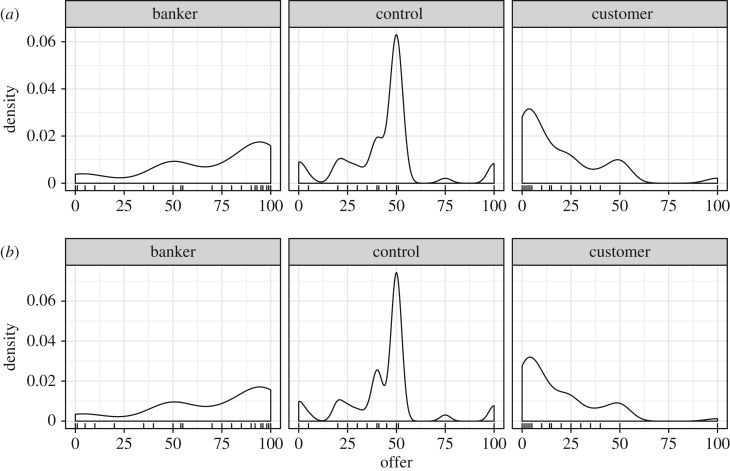
Pilot data. Density plots of all offers by condition, with raw data before exclusion (a) and after exclusion (b); bandwidth = 9.08, rug indicates offers.